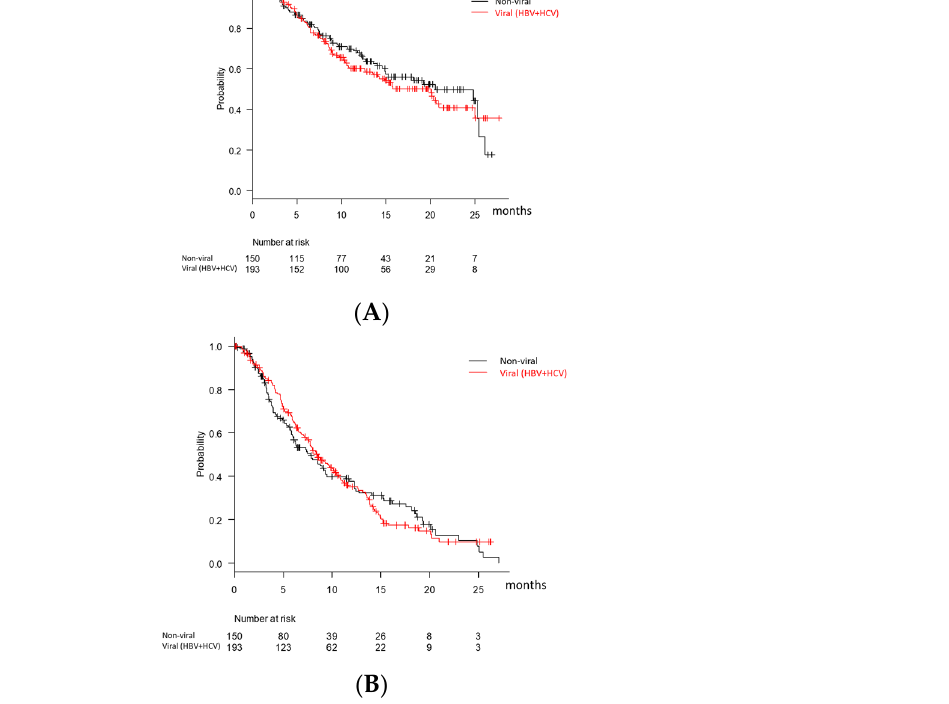
Figure 1. Overall survival ( A ) and progression-free survival ( B ) according to the etiology. 3.3. Overall Survival in Child-Pugh A Patients with Extrahepatic Metastasis and No Major Vascular Invasion As extrahepatic metastatic sites, lung ( n = 65), bone ( n = 34), and adrenal gland ( n = 19) were reported. In Child-Pugh A and MTT naïve patients ( n = 88), the median PFS in the patients with bone metastasis and no MVI was significantly shorter than the patients with lung or adrenal gland metastasis and no MVI (6.3 vs. 12.5 months, p = 0.0025, Figure 2). The median OS between the two groups was not significantly different (20.2 vs. 25.5 months, p = 0.27). There were no significant differences in the pretreatment characteristics, including age, body weight, ALBI score, AST, and AFP level between the two